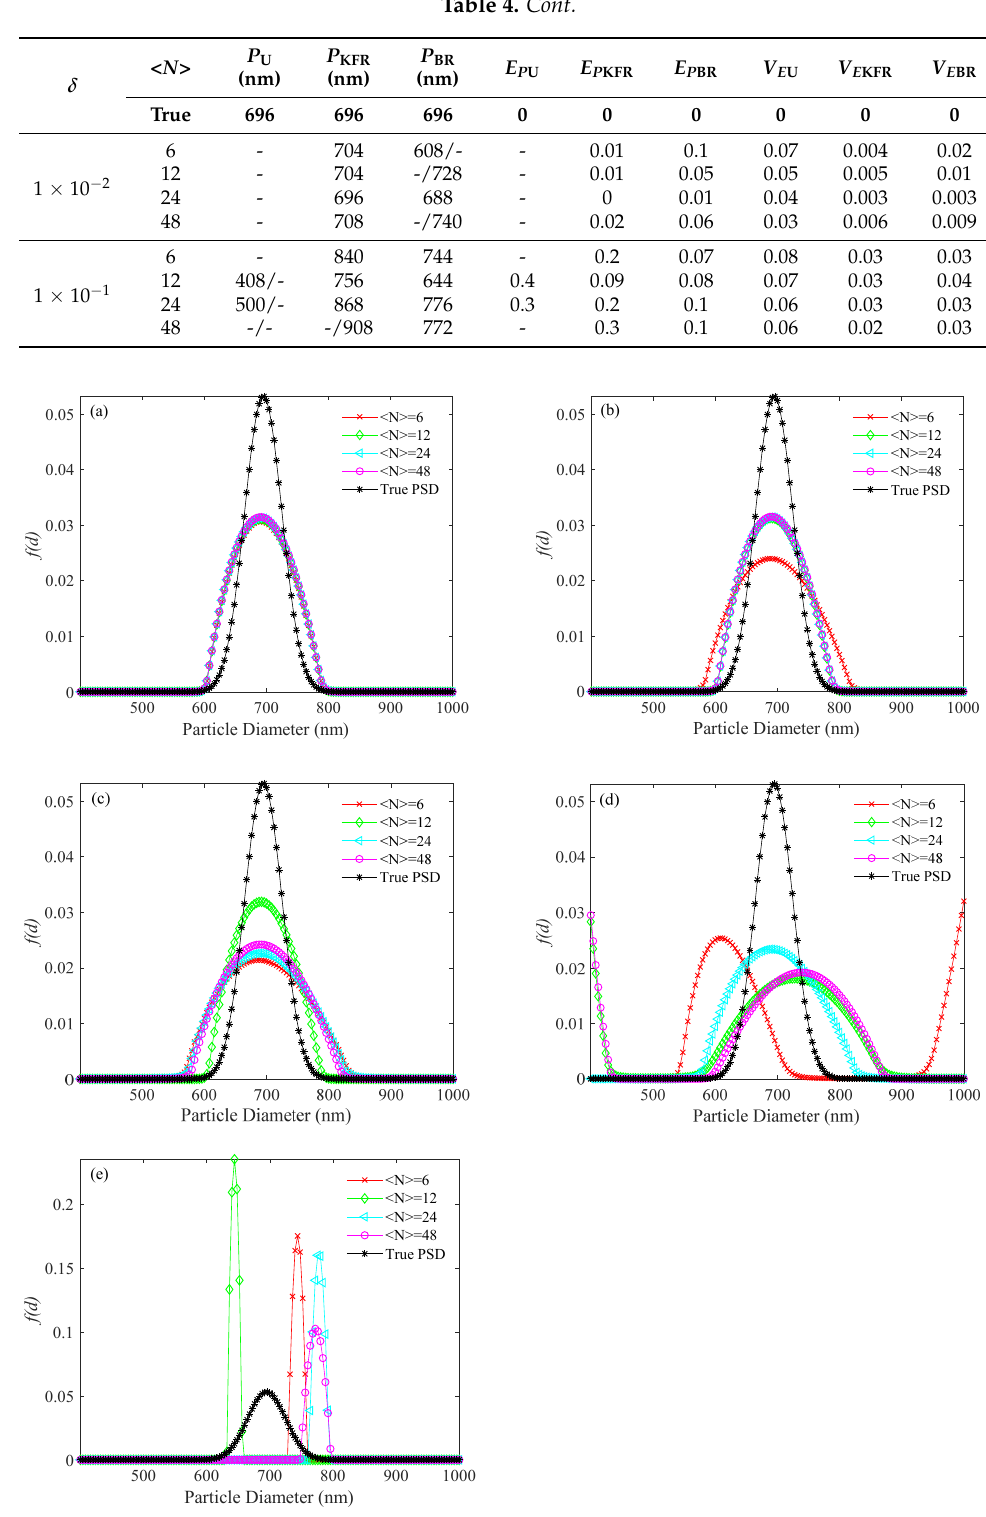
Figure 9. PSD recovered by the BR method for a 696 nm unimodal sample at number concentrations of < N > = 6, 12, 24, 48, and different levels of noise. ( a ) 0, ( b ) 10 − 4 , ( c ) 10 − 3 , ( d ) 10 − 2 , and ( e ) 10 − 1 noise levels. Table 4. Performance indices for the recovery of the 696 nm PSD by using three methods.